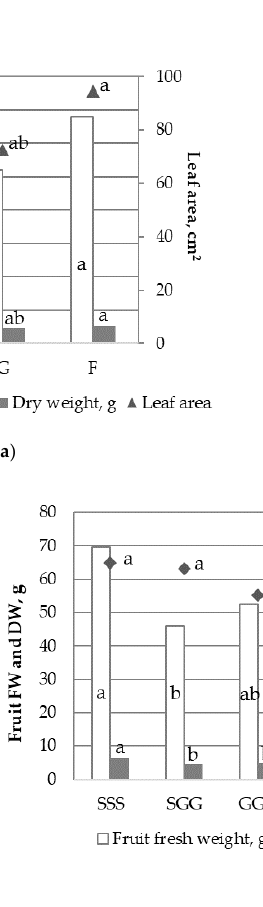
Figure 2. Growth and yield parameters of tomato, illuminated with different light spectrum during growth stages: ( a ) plant growth parameters during seedling stage; ( b ) plant growth parameters during growth stage; ( c ) fruit yield obtained in fruiting stage. Different letters indicate statistically significant differences between means according to Fisher’s test at the confidence level p = 0.05. S, G and F—lighting spectrum, selected for “seedling”, “growth” and “fruiting” stages respectively and alternated in seedling (S, G, F), biomass growth (SS, SG, GG, FF) and fruiting (SSS, SGG, GGG, GGF, FFF, SGF) tomato growth stages.